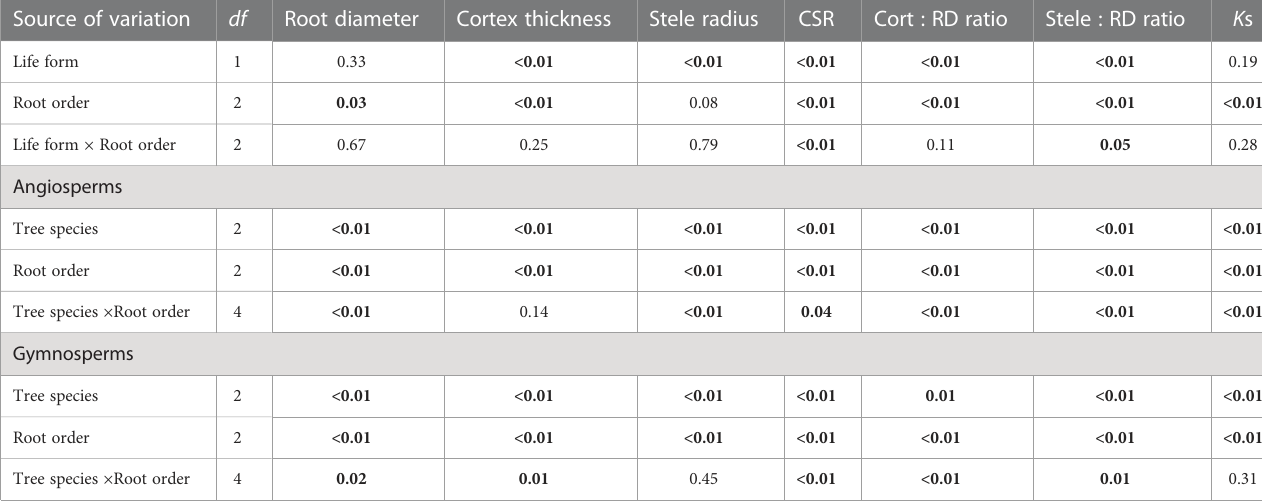
TABLE 8 ANOVA results ( p value) of life form ( i.e ., angiosperms and gymnosperms), root order and their interaction effect, as well as tree species, root order and their interaction effect for each life form on absorptive root diameter and anatomical traits. Source of variation